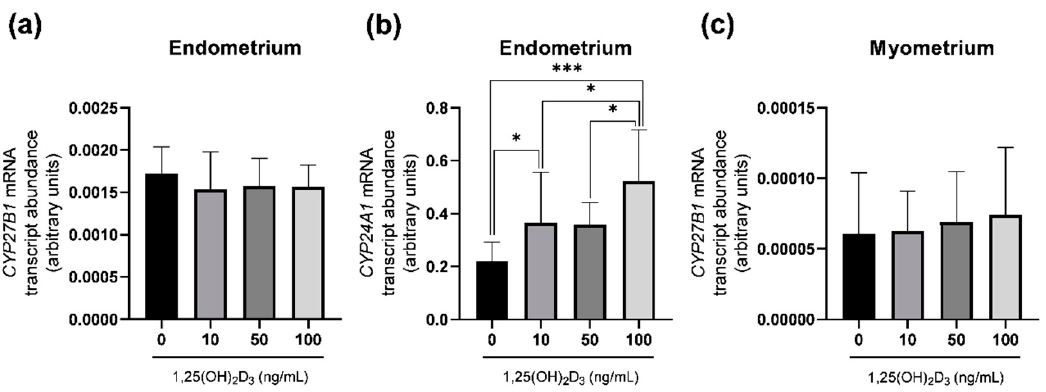
Figure 6. In vitro effect of 1,25(OH) 2 D 3 (0, 10, 50 and 100 ng/mL) on CYP27B1 and CYP24A1 mRNA transcript abundance in endometrial slices ( a , b , respectively), and CYP27B1 mRNA transcript abundance in myometrial slices ( c ) harvested on days 12–13 of the estrous cycle. Relative mRNA transcript abundance (quantitative real–time PCR) is expressed as the ratio relative to GAPDH (glyceraldehyde–3–phosphate dehydrogenase) and is presented as 2 − ∆ Ct . Each value represents the mean ± SD: * p < 0.05; *** p < 0.001 (one-way ANOVA followed by Tukey post hoc test); n = 5 per each group.